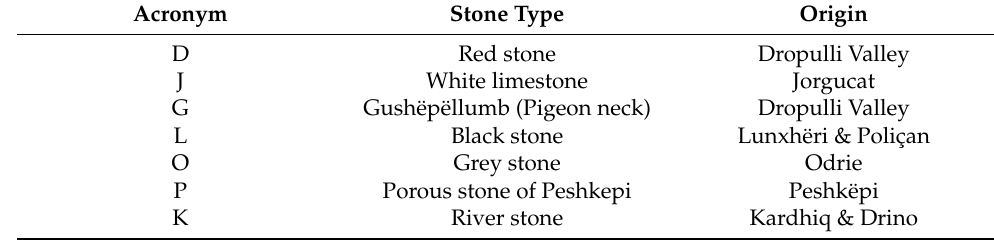
Table 1. The building stone coding according to their origin.